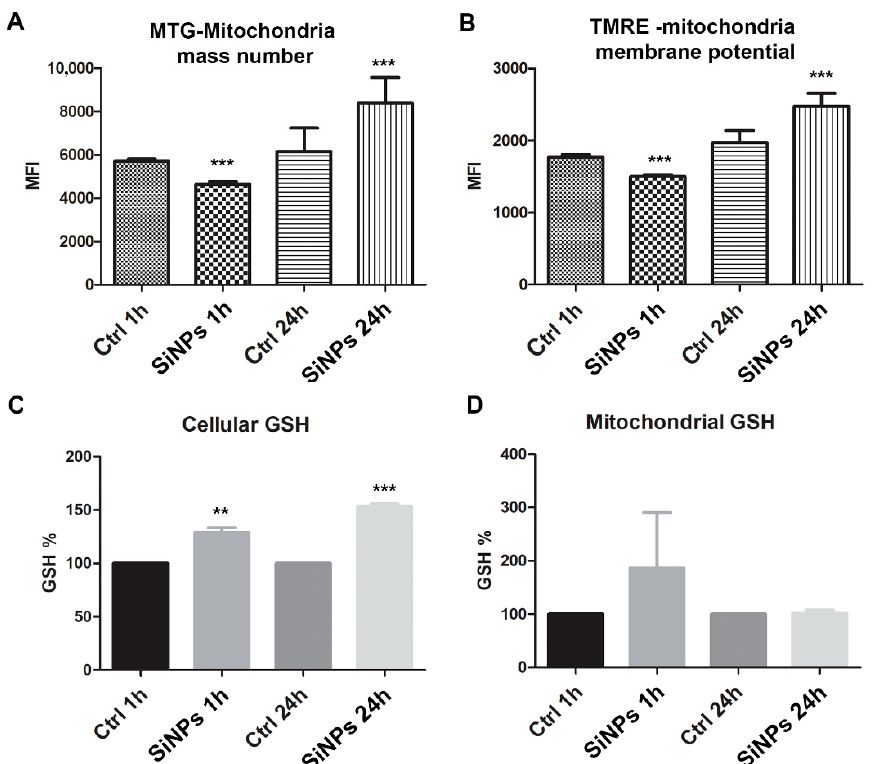
Figure 3. Assessment of mitochondrial features of isolated mitochondria from U937 cells incubated for short or long time with SiNPs. Quantification of mitochondrial mass with MTG staining ( A ) and mitochondrial membrane potential (MMP) △ Ψ m with TMRE ( B ) through flow cytometry analysis of control and treated cells for 1 and 24 h. Determination of cellular ( C ) and mitochondrial ( D ) glutathione (GSH) content in U937 cells incubated with NP for 1 h or 24 h by high performance liquid chromatography (HPLC). GSH content of untreated U937 cells was 35.0 ± 5 nmol/mg proteins in cells and 3.0 ± 0.55 nmol/mg proteins in mitochondria. Asterisks denote a statistically significant difference (** = p < 0.01, *** = p < 0.001) of treated compared to the relative control. At least 10,000 events were analyzed by flow cytometry for each experimental condition.